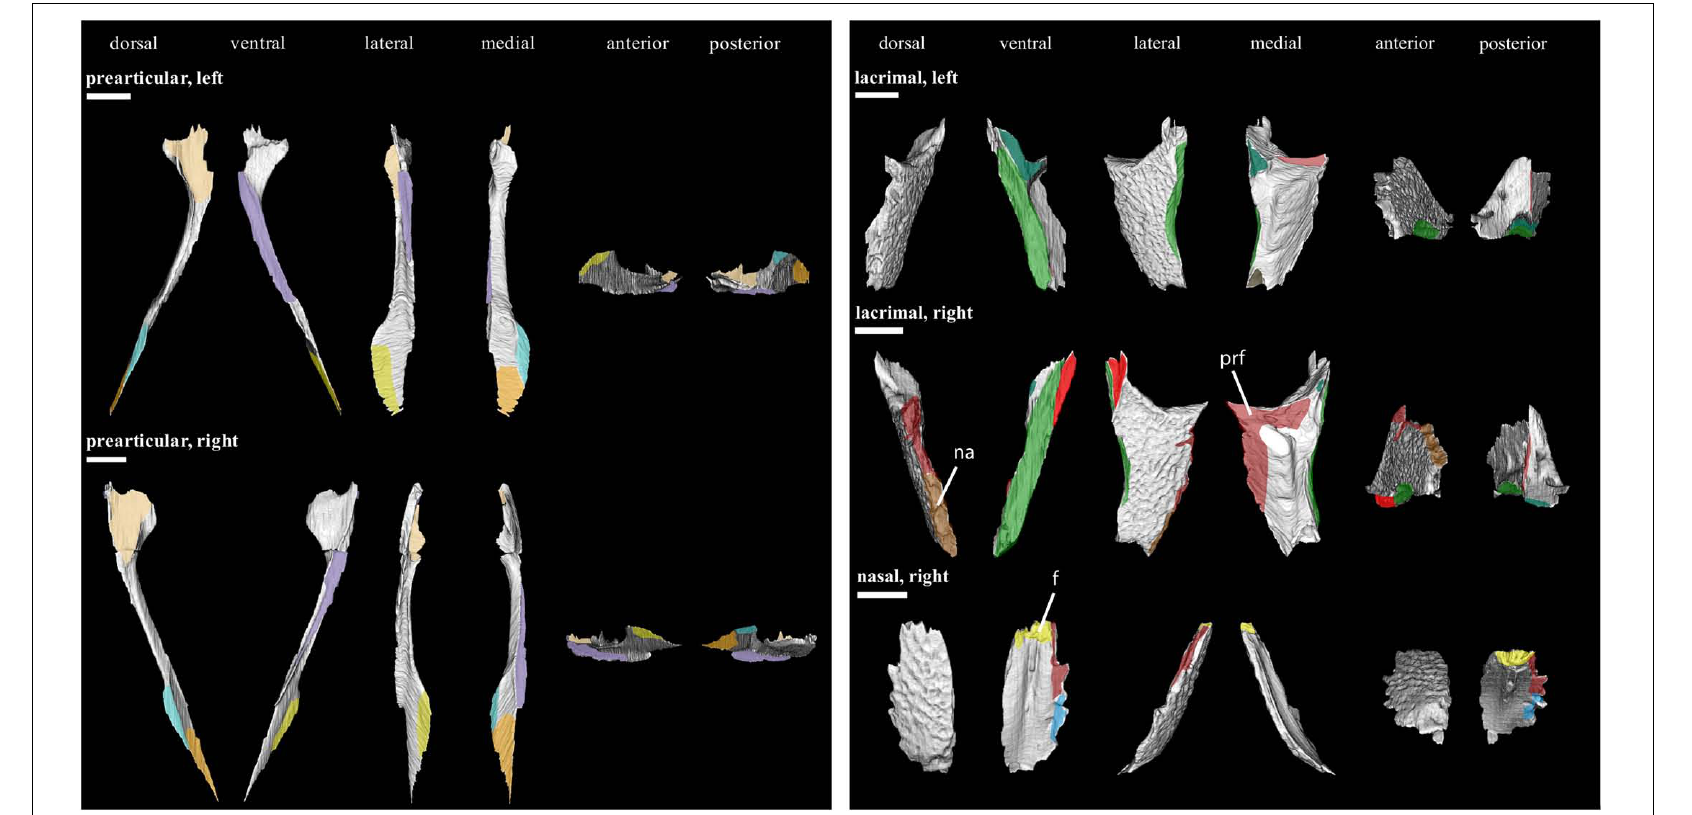
FIGURE 5 | Isolated bones in dorsal, ventral, lateral, medial, anterior and posterior views. Articulation areas with other bones are colored. Left and right prearticular, left and right lacrimal, and right nasal are shown. Scale bar = 10 mm. For abbreviations see caption to Figure 1